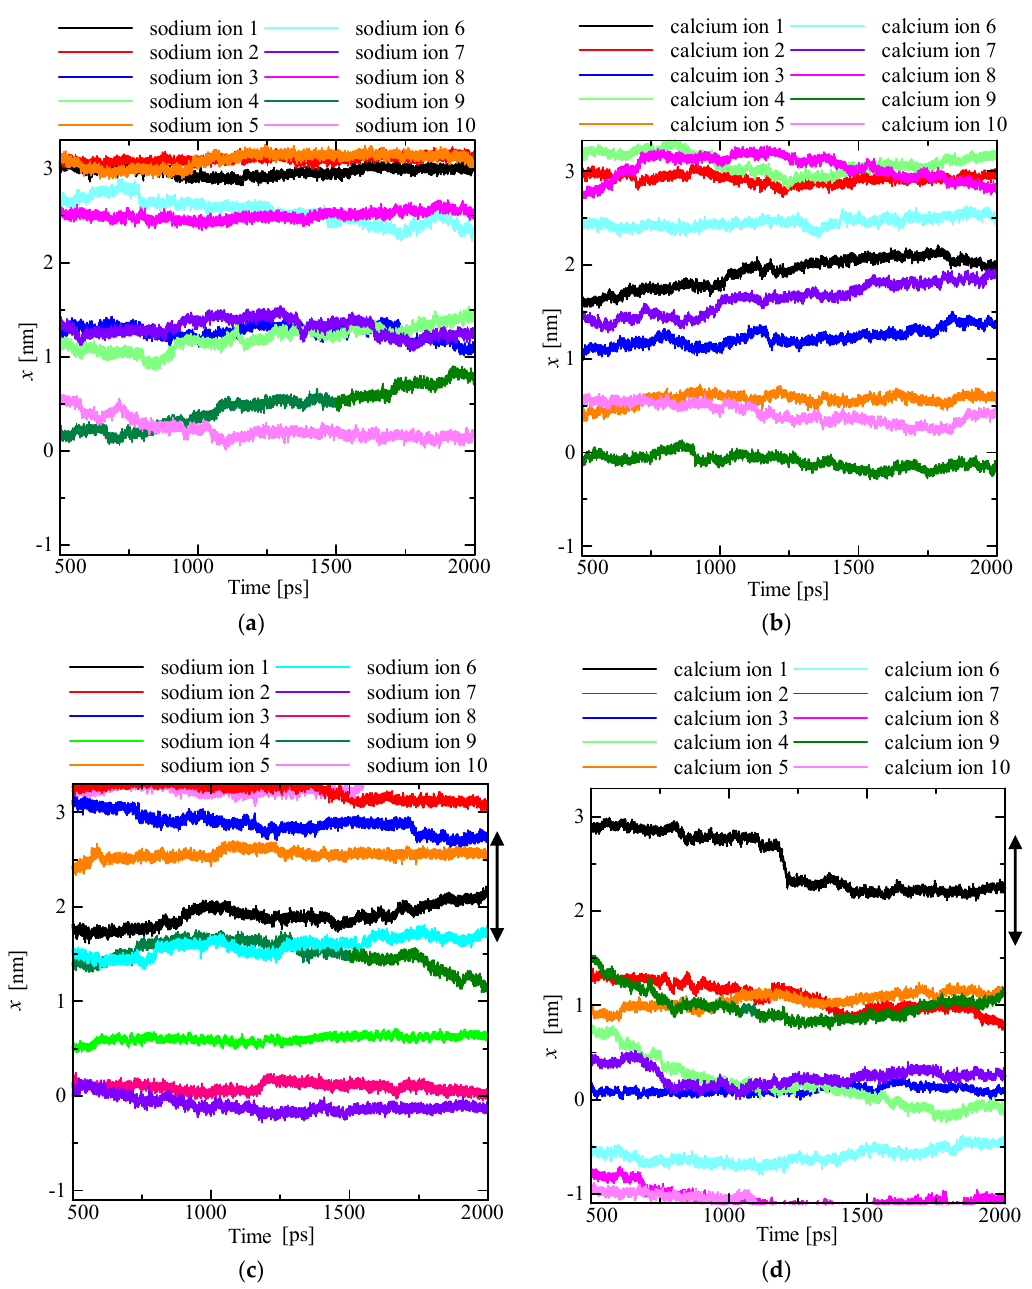
Figure 2. Time changes in the positions of ions; ( a ) Sodium ions in the NaCl solution, ( b ) Calcium ions in the CaCl 2 solution, ( c ) Sodium ions in the mixed solution, ( d ) Calcium ions in the mixed solution. The ice layer was located in the range of −3.366 < x < −1.123 [nm] during the period. The arrows in ( c ) and ( d ) show the range of location of HPLC6 during the period.